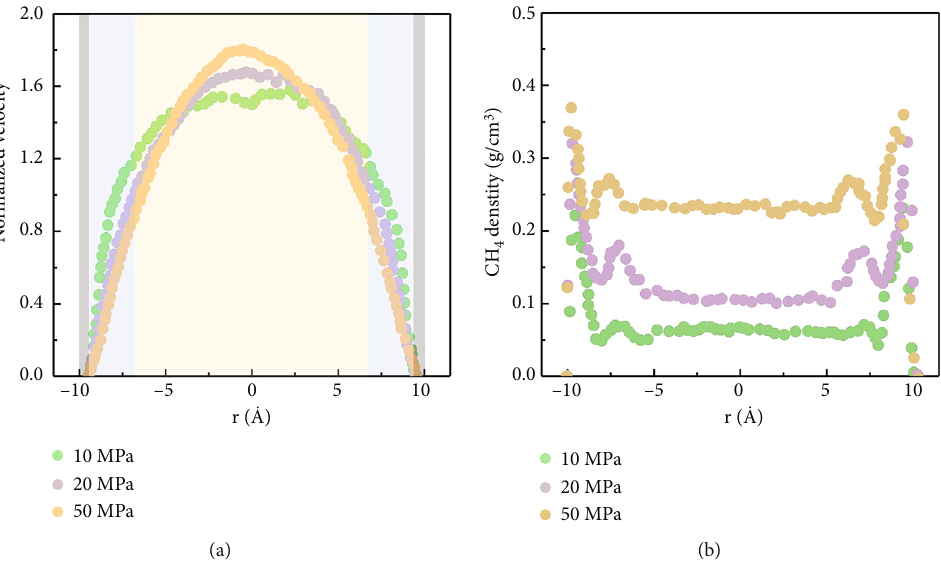
Figure 8: Normalized velocity and CH density distribution in the nanopores of type-II kerogen under di ff erent pore 4